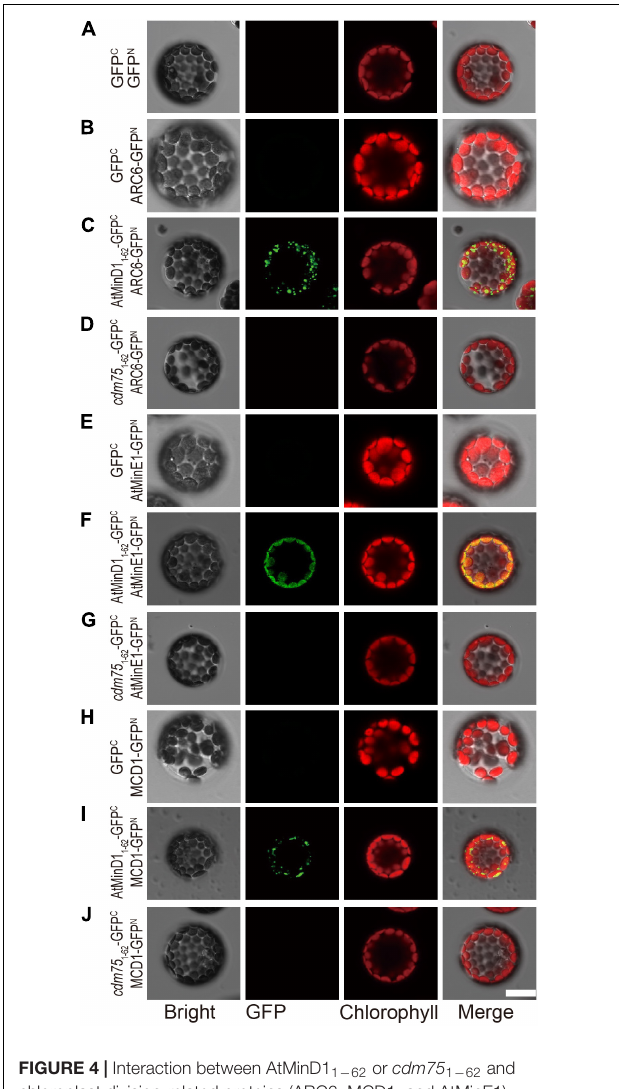
FIGURE 4 | Interaction between AtMinD1 1 − 62 or cdm75 1 − 62 and chloroplast division-related proteins (ARC6, MCD1, and AtMinE1) determined using the BiFC assay in Arabidopsis protoplasts. Bimolecular fluorescence complementation (BiFC) assays were performed by co-expression of the indicated combinations of plasmids in protoplasts isolated from wild-type Arabidopsis plants. Fluorescence of the reconstituted GFP fluorophore was detected by epifluorescence microscopy. Different types of protoplasts with (A) co-expression of 35S-GFP C and 35S-GFP N ; (B) co-expression of 35S-GFP C and 35S-ARC6-GFP N ; (C) co-expression of 35S-AtMinD1 1 − 62 -GFP C and 35S-ARC6-GFP N ; (D) co-expression of 35S- cdm75 1 − 62 -GFP C and 35S-ACR6-GFP N ; (E) co-expression of 35S-GFP C and 35S- AtMinE1-GFP N ; (F) co-expression of 35S-AtMinD1 1 − 62 -GFP C and 35S-AtMinE1-GFP N ; (G) co-expression of 35S- cdm75 1 − 62 -GFP C and 35S- AtMinE1-GFP N ; (H) co-expression of 35S-GFP C and 35S-MCD1-GFP N ; (I) co-expression of